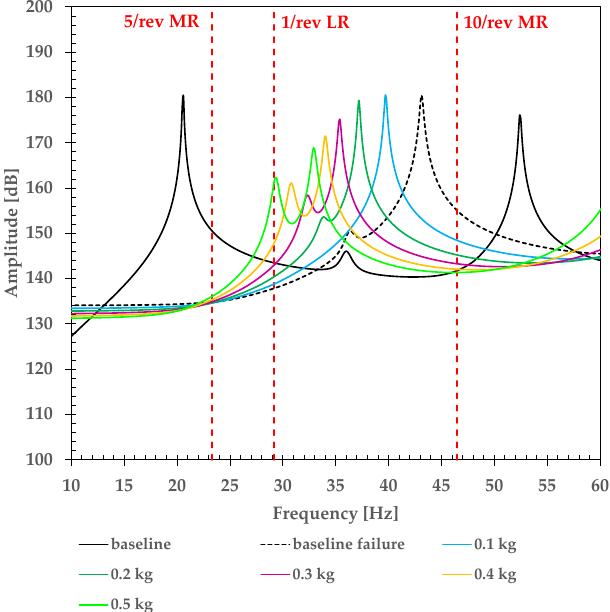
Figure 15. Extra-mass addition on the MLG door: rod link failure. Table 6. Matrix of failure cases with a deployed door: natural frequencies trend. MLG Door Configuration